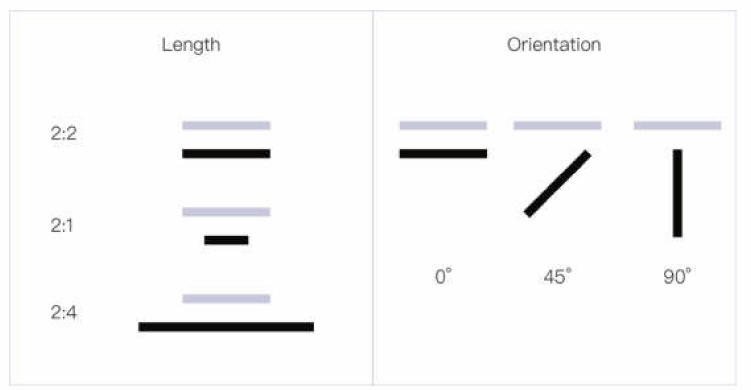
Figure 2. The two factors in the experiment. Each factor used a control group and two experimental groups. The gray color indicates a reference line and the black color indicates a stimulus